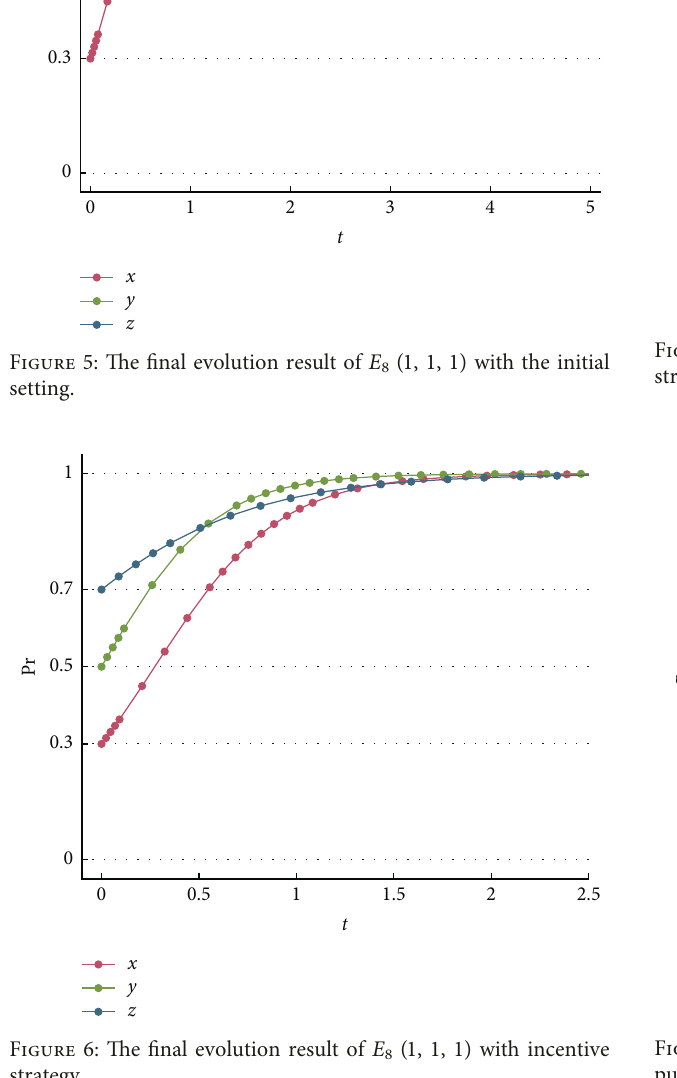
8 (1, 1, 1) with incentive